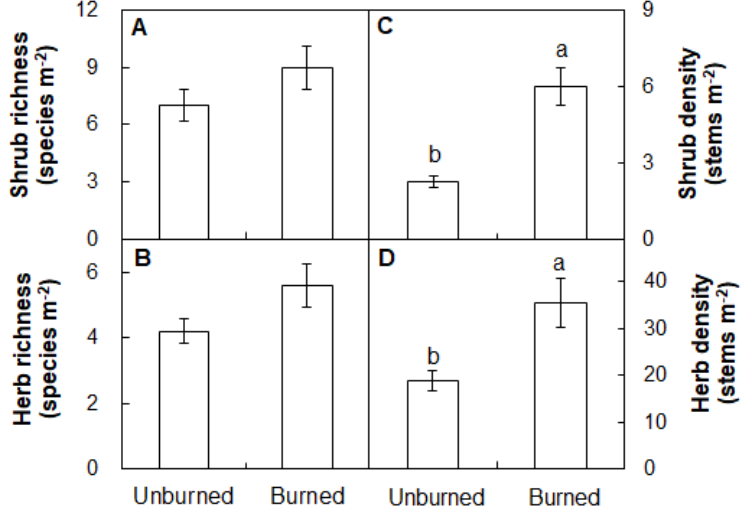
Figure 8. Di ff erences in richness ( A , B ) and density ( C , D ) of shrub and herbaceous species between the Figure 8. Differences in richness ( A and B ) and density ( C and D ) of shrub and herbaceous species unburned and burned plots. Di ff erent letters indicate significant di ff erences between treatments at between the unburned and burned plots. Different letters indicate significant differences between p < 0.05. Values are presented as the means ± standard treatments at p < 0.05. Values are presented as the means ± standard error.